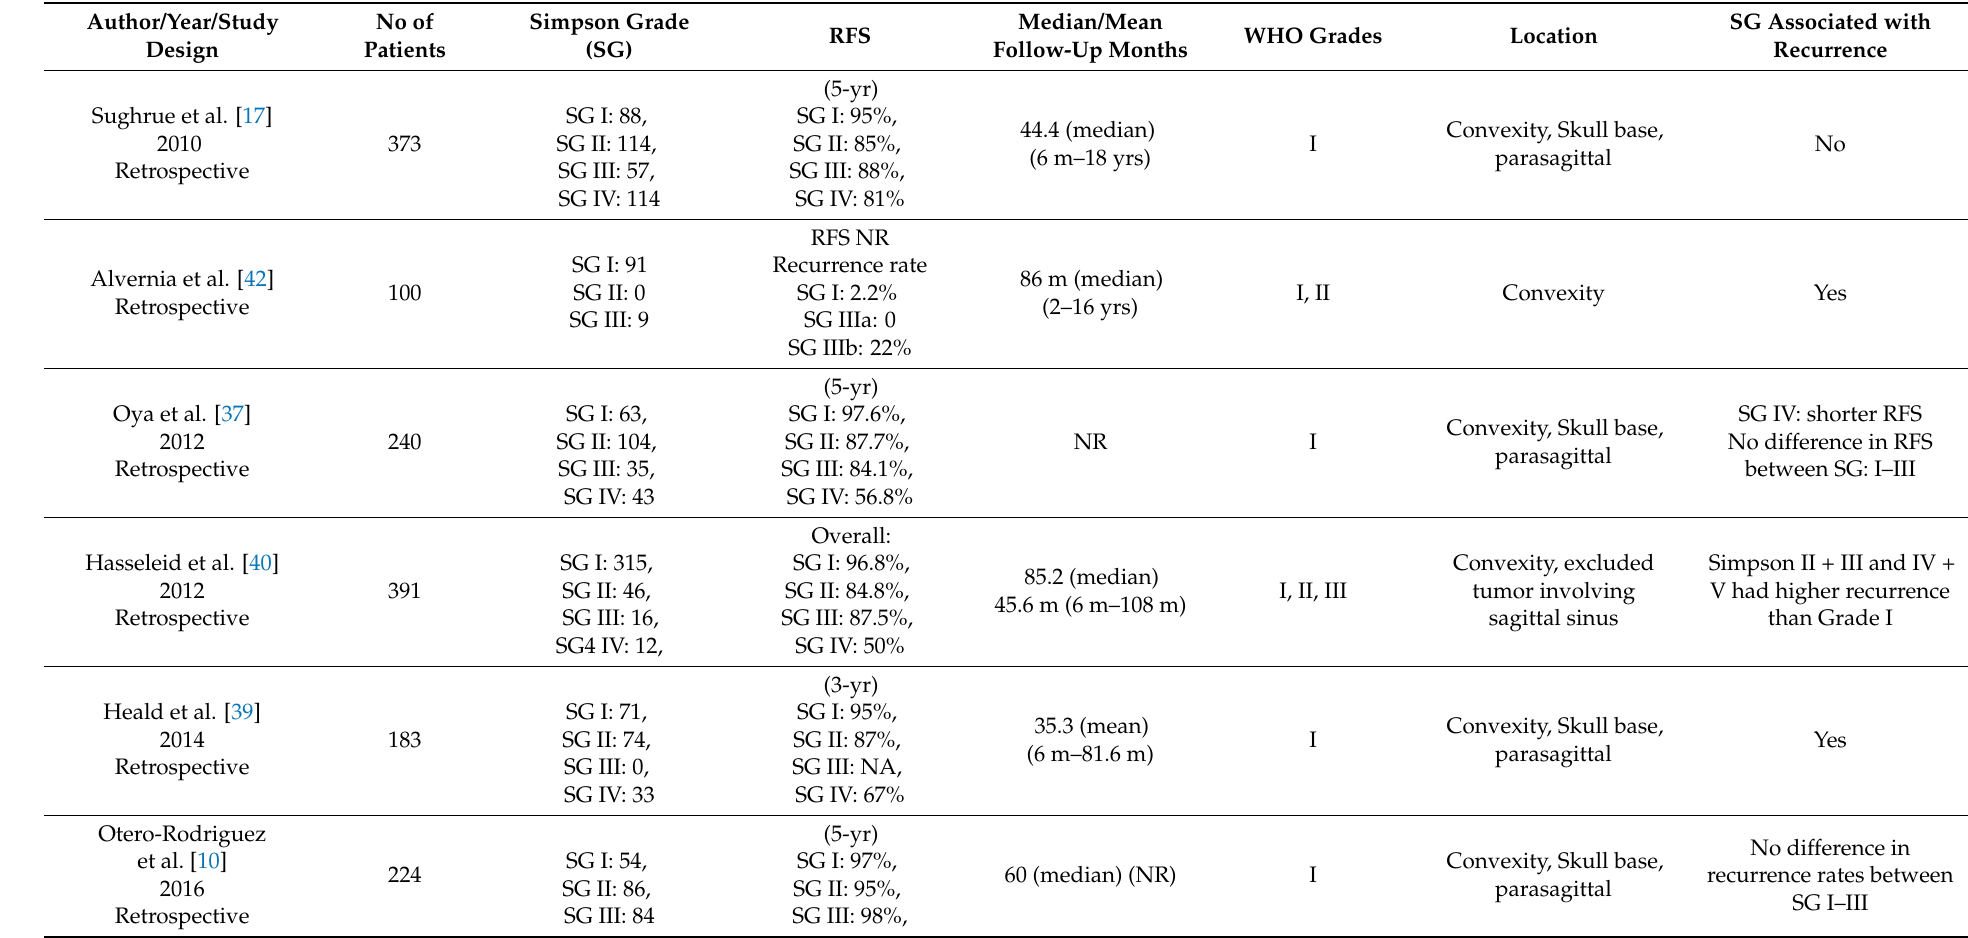
Table 2. Summary of recent studies reporting the Simpson Grade and its association with recurrence after meningioma